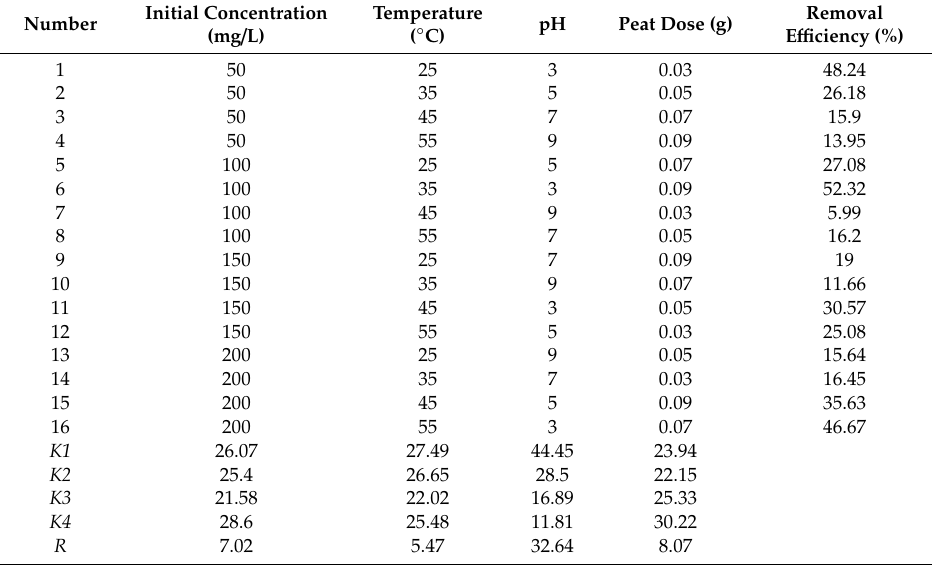
Figure 5. ( A ) Adsorption kinetics, with ( B ) pseudo-first order, ( C ) pseudo-second order and ( D ) Elovich Figure 5. (A) Adsorption kinetics, with (B) pseudo-first order, (C) pseudo-second order and (D) order kinetic plot of Cr adsorption in the aqueous solution. Elovich order kinetic plot of Cr adsorption in the aqueous solution. Table 4. Result of the orthogonal experiment on the removal e ffi ciency influencing